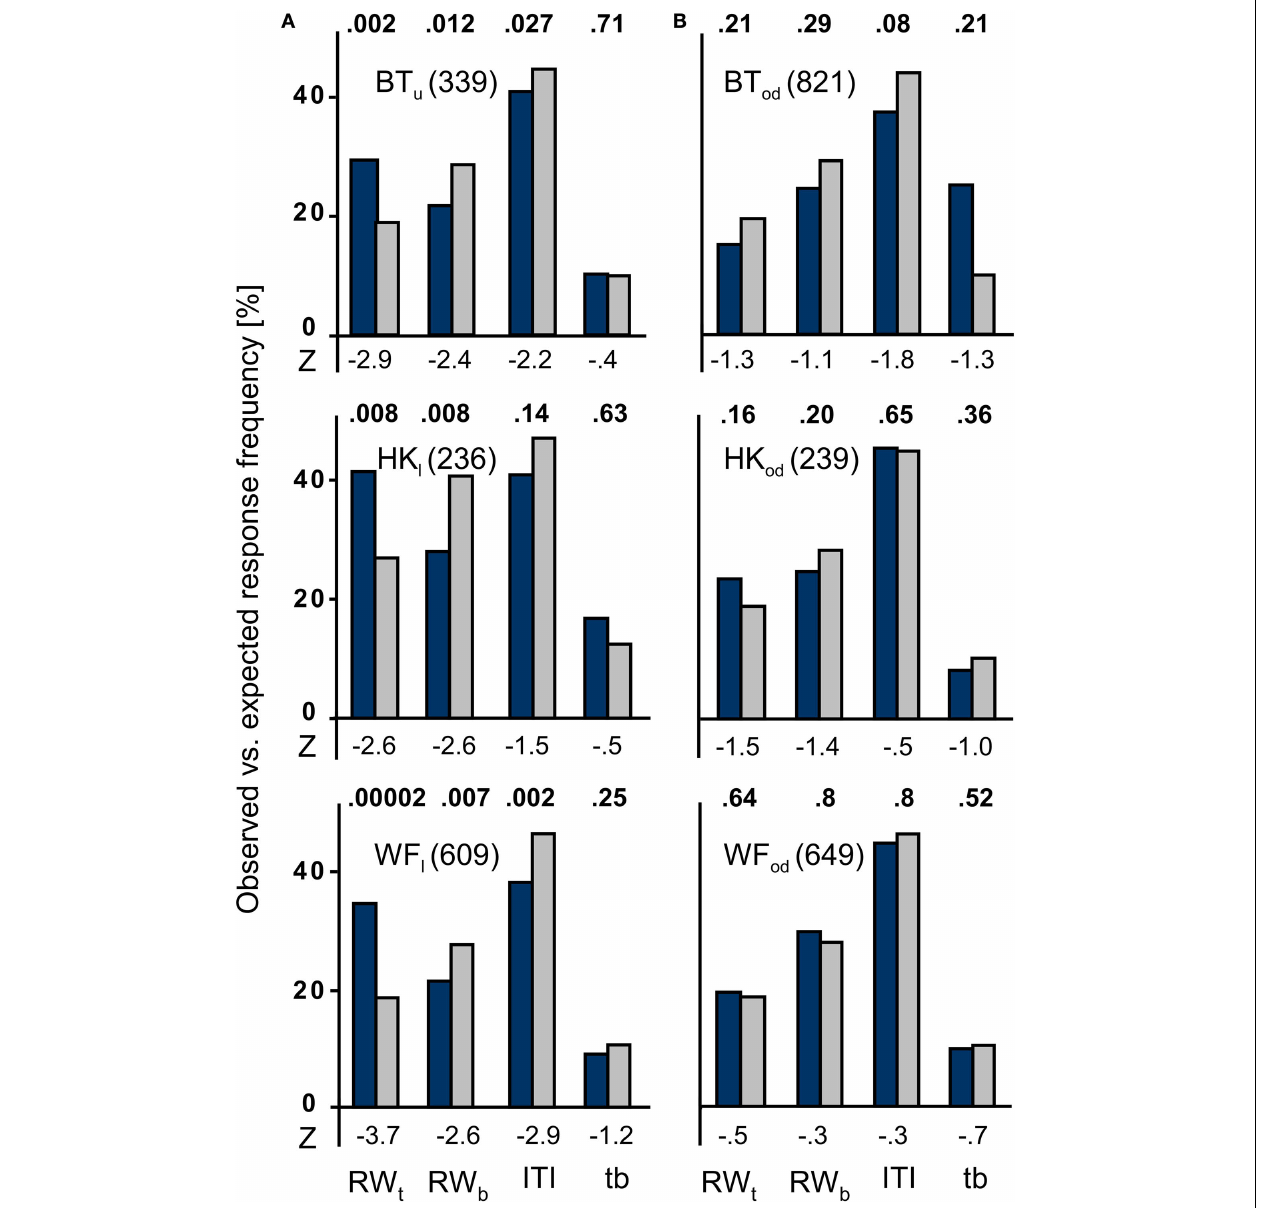
FIGURE 4 | Observed vs. expected response frequencies in the un-cued condition. The blue bars represent the mean observed responses, the gray bars the expected ‘chance’ values that mirror the proportionate duration of event type time windows. The numbers given behind the participants’ initials indicate the total number of responses recorded for the patient at the position indicated by the subscript index. (A) Data for the subjectively blind fi eld are given in the left column. Note that only the correct responses, i.e. those that